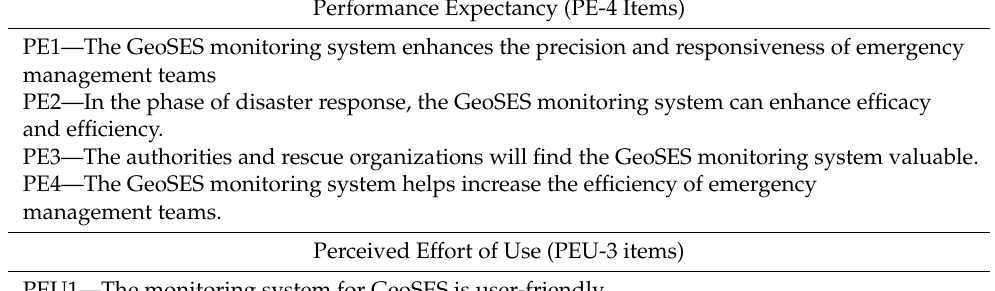
Table 2. Questionnaire regarding the beneficiaries’ perception of the use of GeoSES-MS. Performance Expectancy (PE-4 Items)